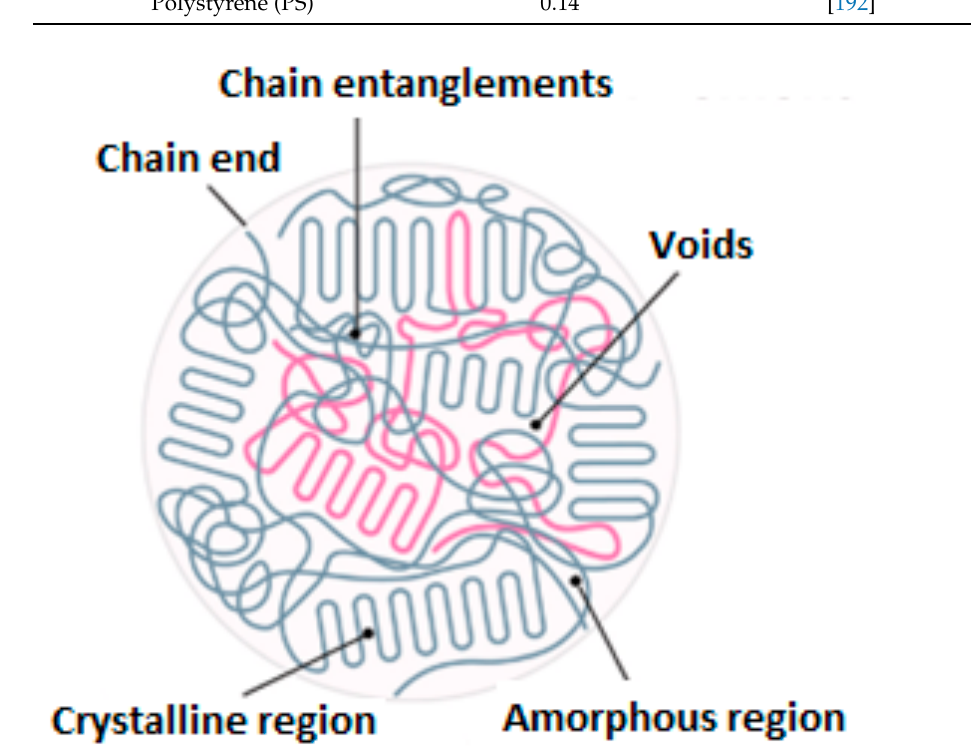
Figure 63. Demonstration of amorphous and crystalline polymer–matrix structures, adapted with permission from Ref. [192]. Copyright © 2021 Elsevier